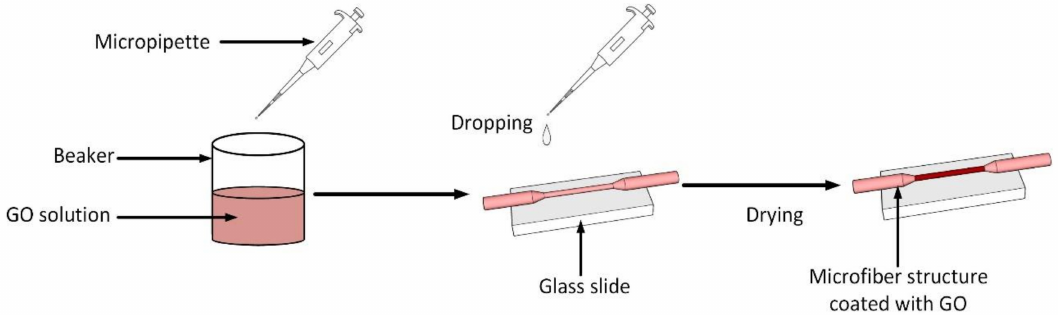
Figure 1. Schematic diagram for graphene oxide (GO) coating procedure onto optical